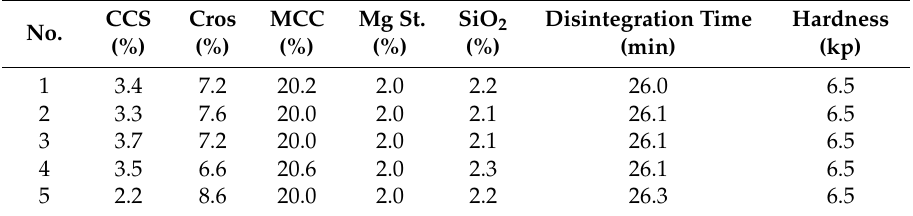
Figure 2. Response surface plots of the relationships among the formulation variable levels, croscarmellose sodium (CCS, Ac-Di-Sol ® ), crospovidone (Cros), and microcrystalline cellulose (MCC) in fixed level of magnesium stearate (Mg St, 2.0%) and silicon dioxide (SiO 2 , 3.0%) at the level of 65% Wuzi Yanzong dry powder extract; ( a ) effects on disintegration time; ( b ) effects on hardness; and ( c ) the overlaid contour diagram of ( a ) and ( b ) for the design space. The yellow areas (design space) show the region where the best responses can be obtained. Table 7. Optimal points obtained from design spaces for Wuzi Yanzong extract tablet formulation containing 65% Wuzi Yanzong dry powder extract and the resulting response, disintegration time, and hardness.